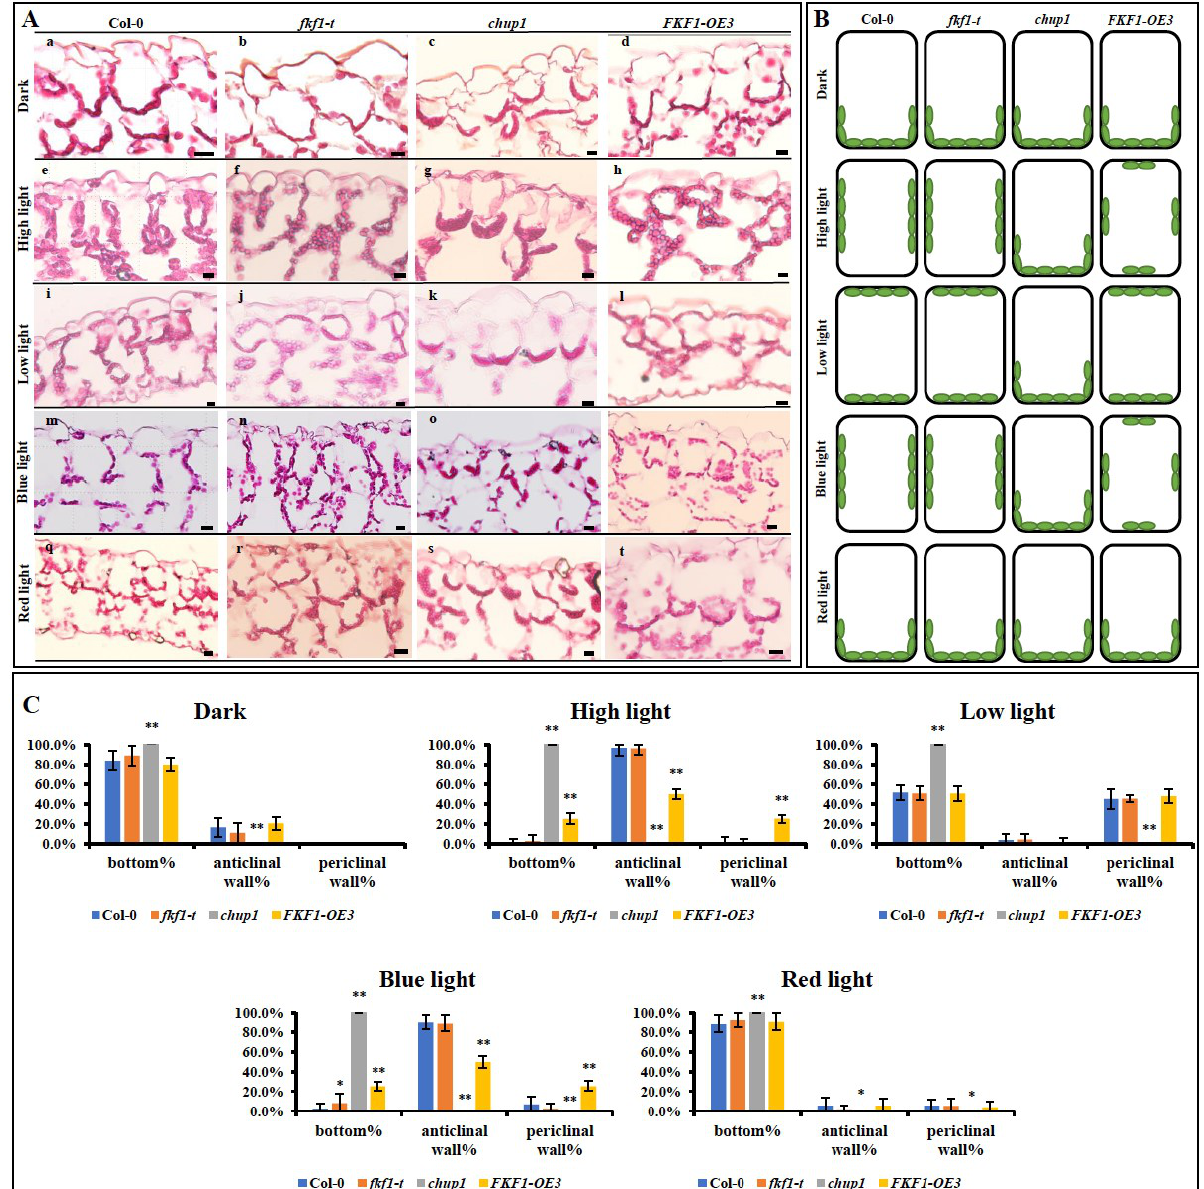
Figure 2. Analysis of photorelocation of chloroplasts in the palisade cells under various light condi- tions. ( A ) Leaf cross-sectioning analysis shows that the high light-induced alignment of chloroplasts on the anticlinal wall was compromised in the FKF1 overexpression line. The Arabidopsis lines (Col- 0, fkf1, chup1, and FKF1 overexpression line) were grown under long-day white light conditions for three weeks and then were transferred to dark, high white light (120 µmol/m 2 /s), low white light (10